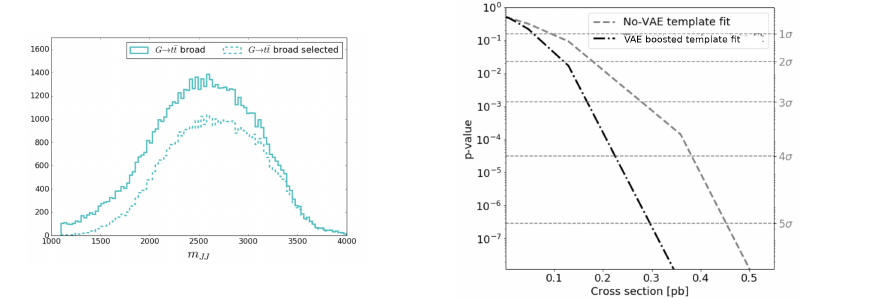
Figure 7. G RS → t ¯ t broad benchmark. Left plot: Dijet mass spectrum of total (solid line) vs selected (dashed line) events after loss cut. Right plot: Cross section and p-value significance for analysis on original dataset (grey line) and VAE loss cut filtered dataset (black line).